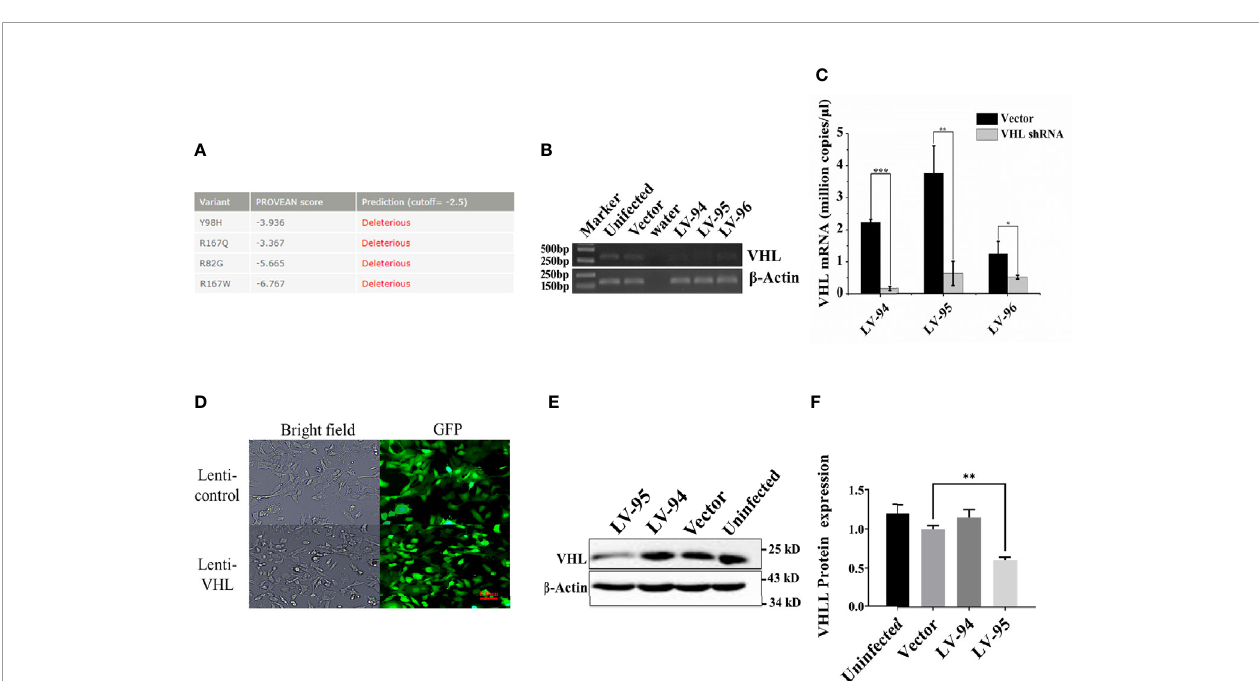
FIGURE 1 | Constructing a VHL-KD PC12 cell line using shRNA. (A) The Protein Variation Effect Analyzer (PROVEAN) was used to fi lter sequence variants to identify non-synonymous or indel variants. The default threshold was − 2.5. The variants with a score equal to or below − 2.5 were considered “ deleterious, ” and the variants with a score above − 2.5 were considered “ neutral. ” (B) We detected the expression of VHL mRNA in PC12 cells by qRT-PCR. At a speci fi c number of cycles, the reaction was stopped, and the PCR product was used to run agarose gel electrophoresis to observe the mRNA relative expression. (C) Compared with the empty vector-transfected group, qRT-PCR veri fi ed the expression of VHL mRNA in VHL-KD and empty vector-transfected group, and each group was subjected to three biological replicates. The bar performed by Mean ± SEM; * P < 0.05, ** P < 0.01, *** P < 0.001, n = 3. (D) After transfection, the GV248 recombinant vector could be stably expressed in PC12 cells. All un-transfected cells were cleared by puromycin [ r (Puro) = 1.5 m g/ml, MOI = 12.5]. (E) Western blot was used to detect the expression of VHL protein in PC12 in the experimental groups. (F) The histogram obtained by gray analysis showed the relative change of proteins (mean ± SEM) n = 3, ** P <